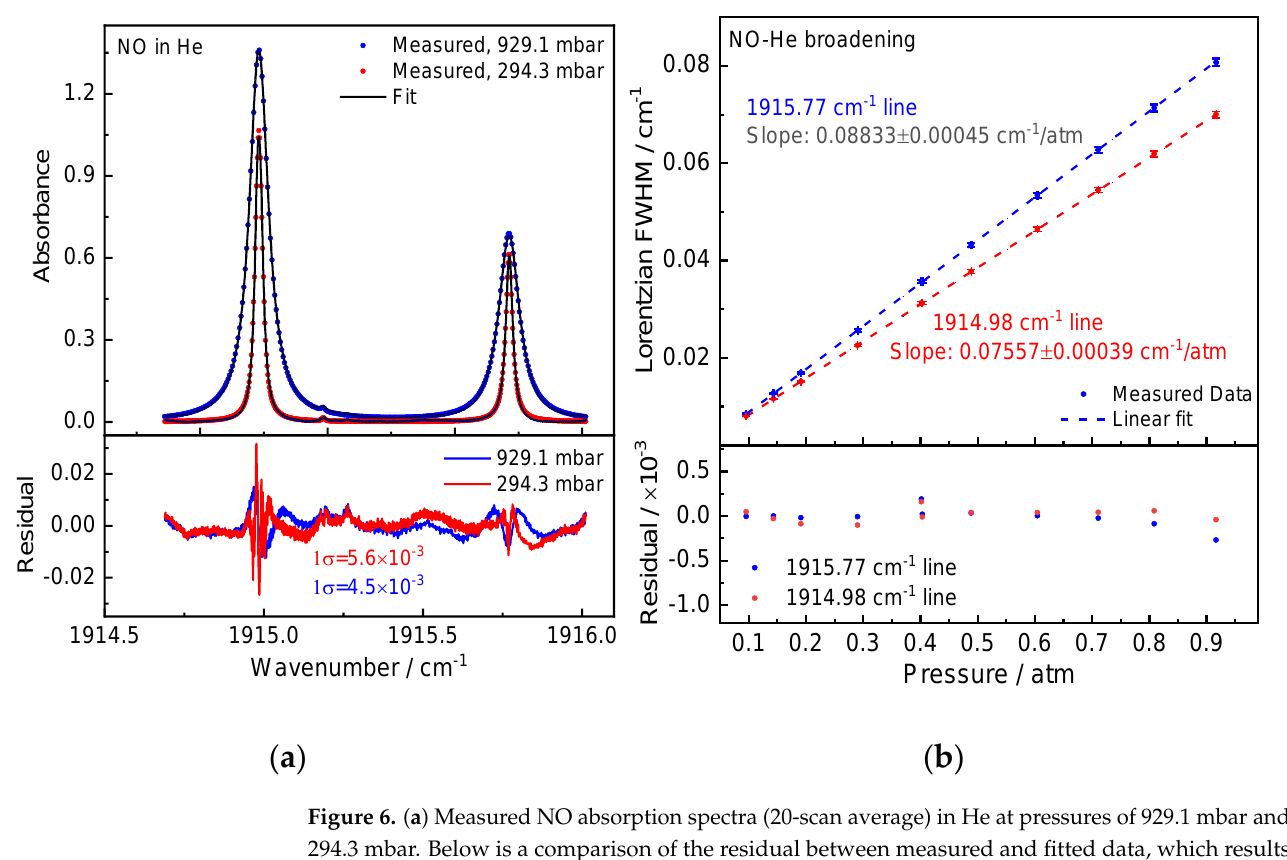
Figure 6. ( a ) Measured NO absorption spectra (20-scan average) in He at pressures of 929.1 mbar and 294.3 mbar. Below is a comparison of the residual between measured and fitted data, which results in an SNR of about 200. ( b ) Measured He-induced pressure broadening of the NO absorption lines fitted with a linear model. Below is a display of the residual between fit and data.